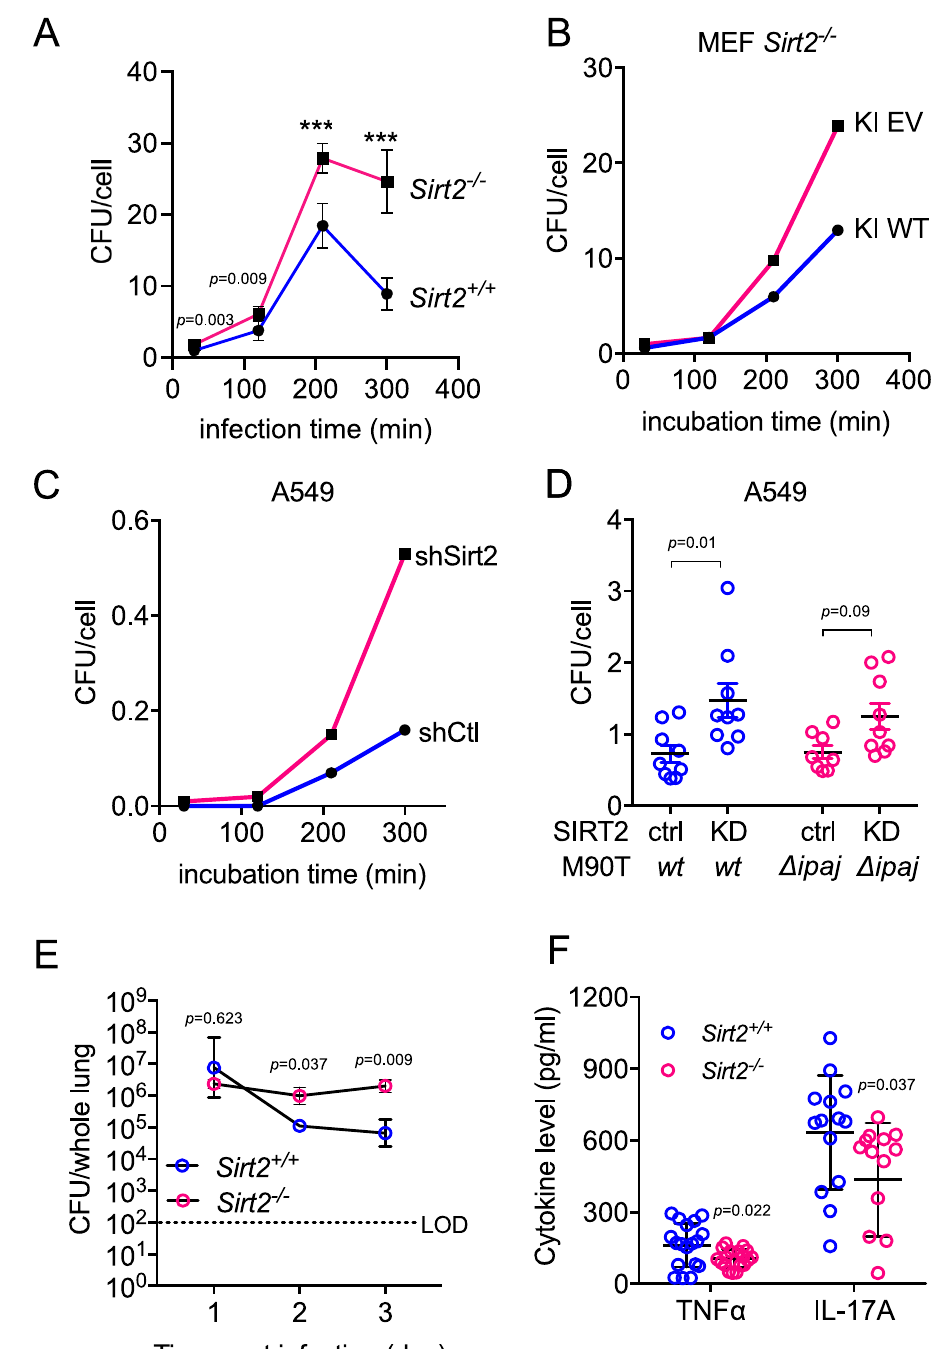
Fig. 7 | SIRT2 restricts Shigella infection in cells and in mice model. A Effect of Sirt2 knockout on S. fl exneri intracellular proliferation analyzed by the gentamycin killing assay. MEF Sirt2 +/+ and Sirt2 -/- cells were infected with S. fl exneri for 10min. Intracellular S. fl exneri number and MEF cell number were counted at indicated time points to get MOI value. Data are presented as mean±SEM with three biolo- gicalreplicates(twotechnicalreplicates).Statisticalevaluation:unpairedtwo-tailed Student ’ s t -test. B , C Effect of SIRT2 knockout on S. fl exneri intracellular prolifera- tion. MOI were determined after 10min of infection and the indicated time of incubationinthepresenceof50 μ g/mlgentamicinin Sirt2 − / − MEFwithemptyvector orSIRT2knock-in(KI, B )andinA549withcontrolorSIRT2knockdown( C )Dataare presented as mean±SEM (the SEM is very small and hard to see in the fi gure) with three biological replicates (two technical replicates). Statistical evaluation: unpaired two-tailed Student ’ s t -test. D A549 control and SIRT2 KD cells were